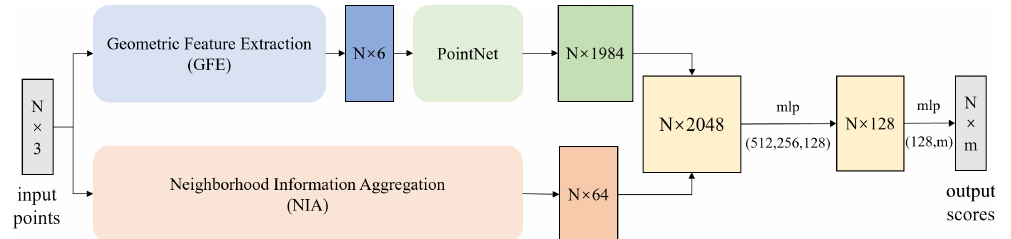
Figure 5. Flowchart of the presented model in this work. The GFE module extracts local geometric features of point cloud. The NIA module aggregates neighborhood feature information. The PointNet module outputs each class score through